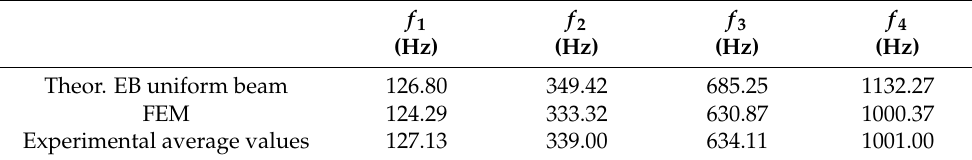
Figure 10. First four vibrational modes obtained by FEM. Table 4. Frequency values ( D 0 ) for the first four modes of vibration B1.